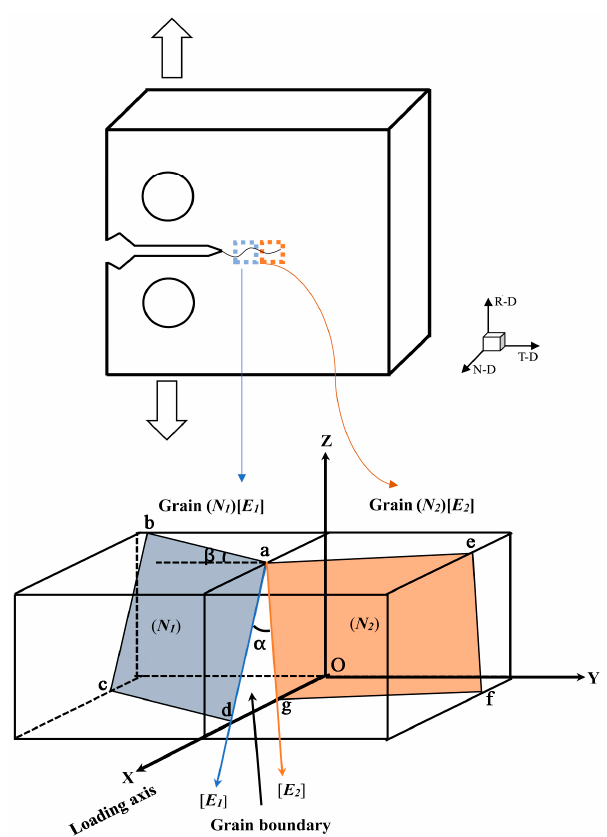
Figure 8. Schematic diagram showing a crystallographic mechanism for fatigue crack growth in Paris regime.